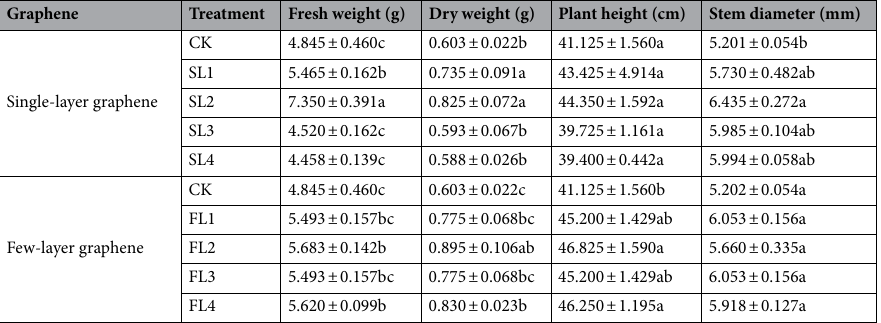
Table 3. Effect of different graphene concentration and type on plant morphology and dry matter content. CK. 0 g kg −1 single-layer graphene and 0 g kg −1 few-layer graphene; SL1 and FL1. 25 g kg −1 single-layer graphene and 25 g kg −1 few-layer graphene; SL2 and FL2. 50 g kg −1 single-layer graphene and 50 g kg −1 few- layer graphene; SL3 and FL3. 100 g kg −1 single-layer graphene and 100 g kg −1 few-layer graphene; SL4 and FL4. 150 g kg −1 single-layer graphene and 150 g kg −1 few-layer graphene; error bars indicate ± standard deviation. Different letters above error bars indicate significant difference between treatment ( p < 0.05, LSD